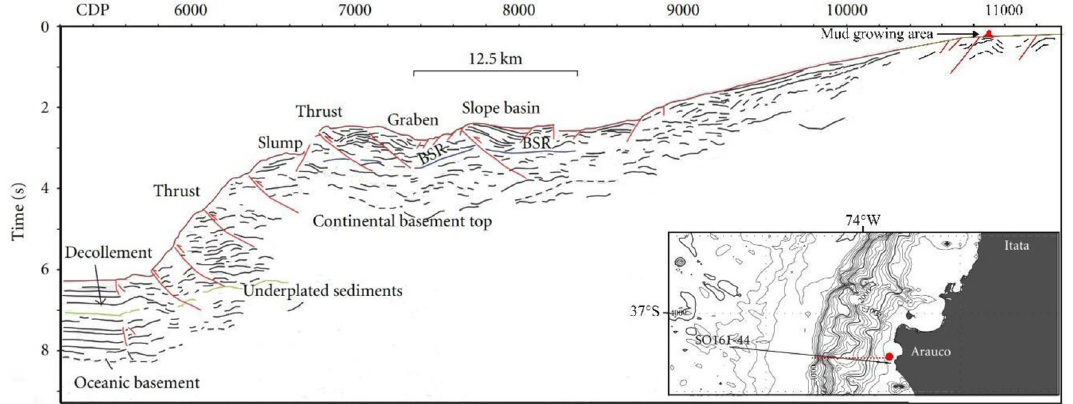
Figure 7. Line drawing section corresponding to the SO161-44 seismic stacking section modified from Fig. 3 in 94 , in which the main geological features and the seismic reflector indicating the transition between gas hydrate and free gas (e.g., the bottom simulating reflector, BSR) are indicated. In the inset, the location map showing static model location reported in Fig. 8 (red dashed line), and mud growing zone (red circle) and the SO161-44 position (black